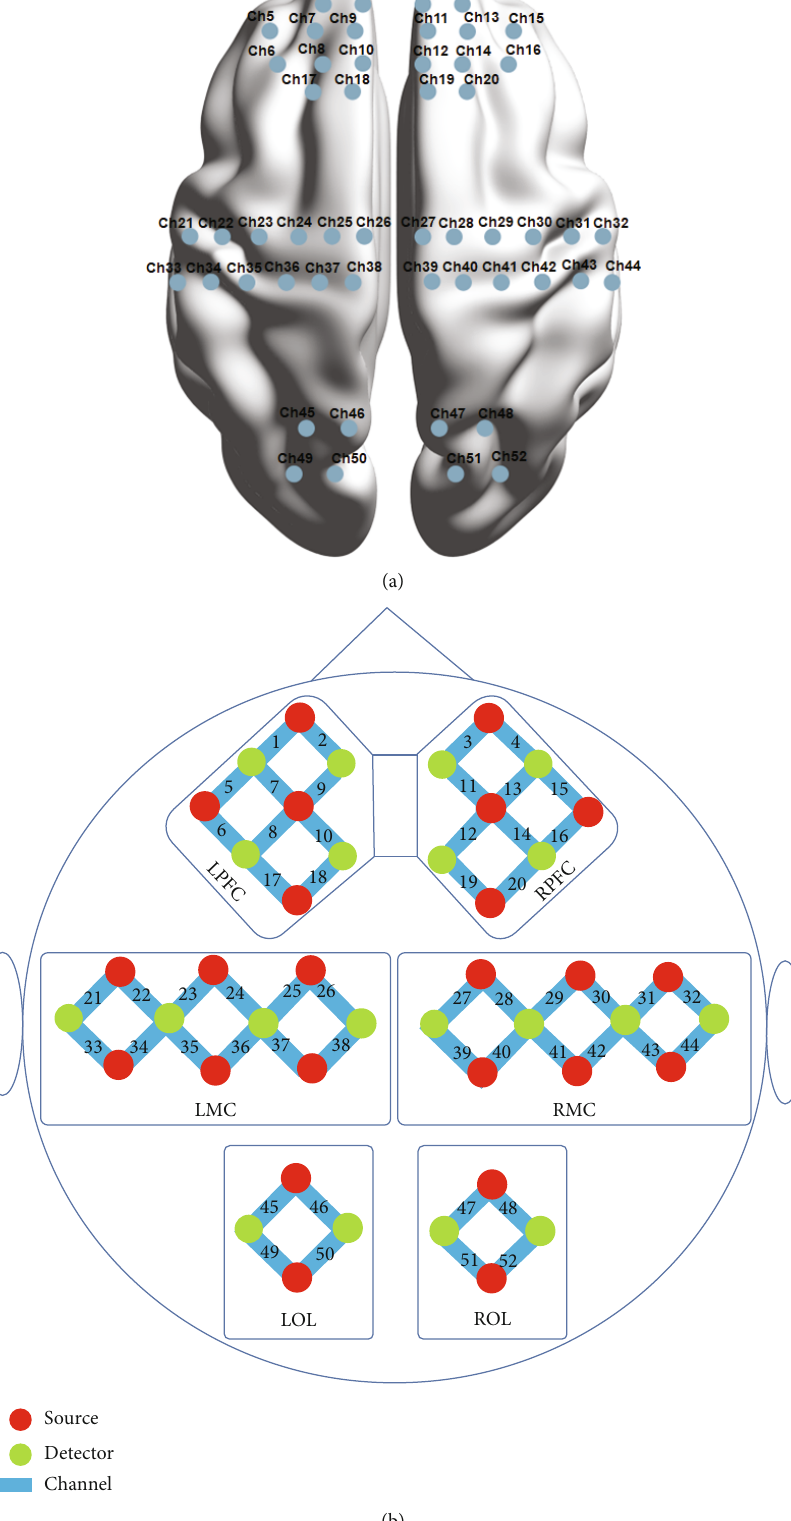
Figure 2: (a) Superior view 3D topography of optode positions in PFC-, MC-, and OL-related regions. (b) Con fi guration of 52 channels corresponding to the 10/10 electrode positions. Ch: channel; L: left; R: right; PFC: prefrontal cortex; MC: motor cortex; OL: occipital